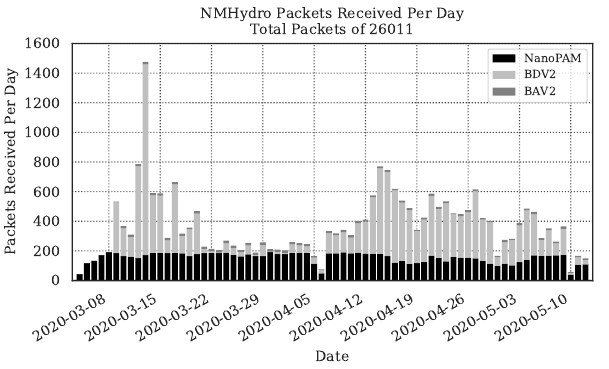
Figure 17. NM software defined receiver packets received per day. A power outage disabled the network from 6th April to 7th April.